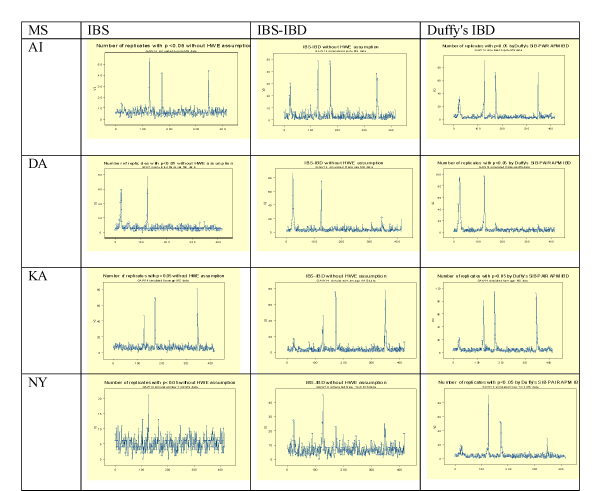
The number of significant (0.05 level) replicates over microsatellite markers.